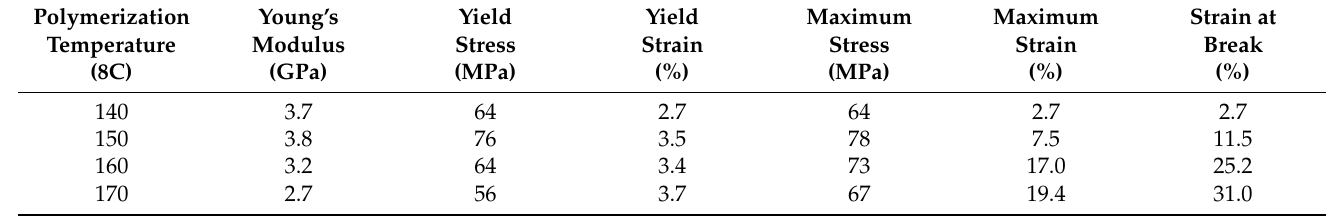
Table 2. Tensile properties of dry as molded (DAM) APA-6. Reprinted from Reference [10], under open-access license.